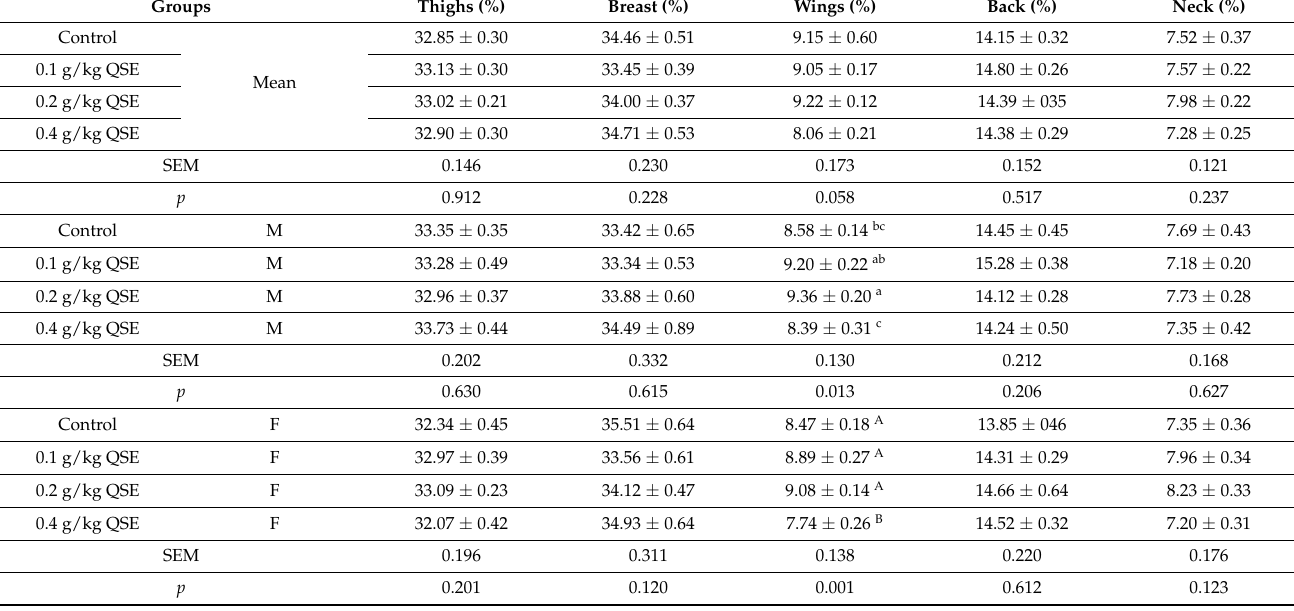
Table 7. Ratios of main carcass parts in carcass (%).